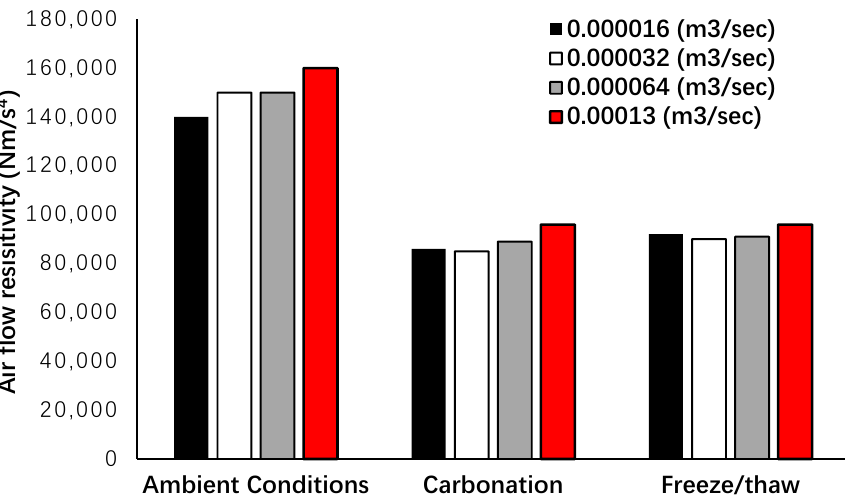
Figure 15. Airflow resistivity of acoustic panels under different conditions.